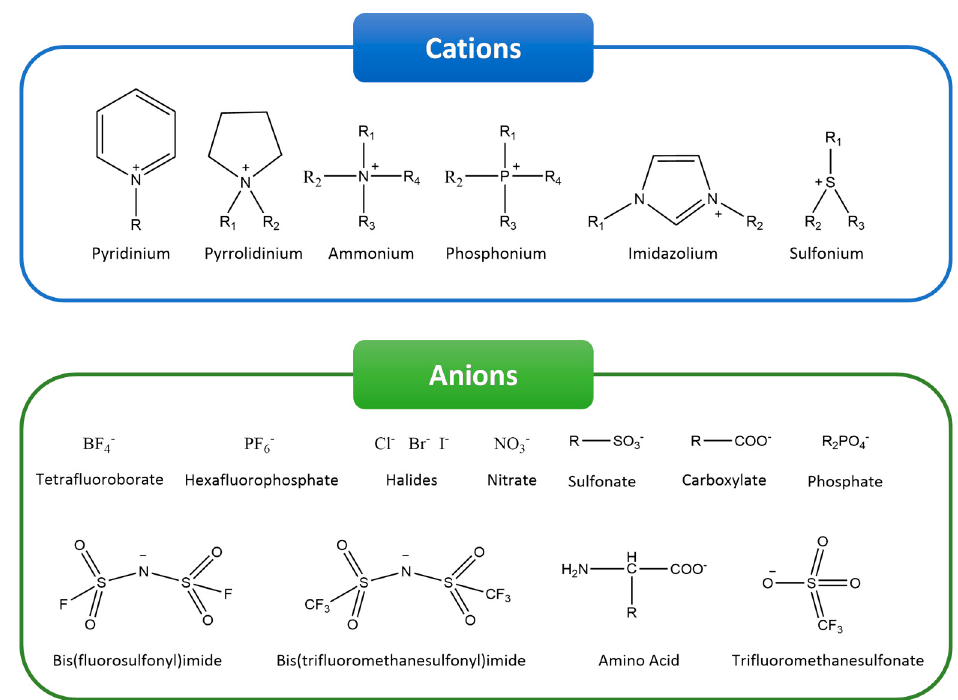
Figure 1. Some common cations and anions present in ionic liquids. Typical bases of the cations are ammonium, imidazolium, sulfonium, piperidinium, and pyridinium ions. Halides, tetrafluoroborate, nitrate, sulfonate, carboxylate, phosphate, and amino acid, among others, serve as anionic bases for the preparation of ILs. Adapted from [2].